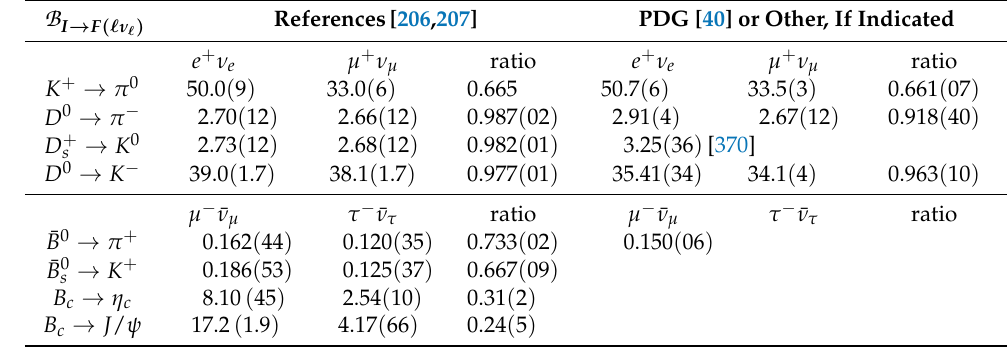
Table 4. CSM predictions for pseudoscalar meson semileptonic branching fractions [206,207]—each such fraction is to be multiplied by 10 − 3 . The column labelled “ratio” is the ratio of the preceding two entries in the row, so no factor of 10 − 3 is applied in this column. (A 1 σ SPM uncertainty is listed for the CSM predictions.) Reference [40] (PDG) lists the following values for the CKM matrix elements: | V us | = 0.2245 ( 8 ) , | V | = 0.221 ( 4 ) , | V cs | = 0.987 ( 11 ) | V | = 0.00382 ( 24 ) ; and the following cd ub